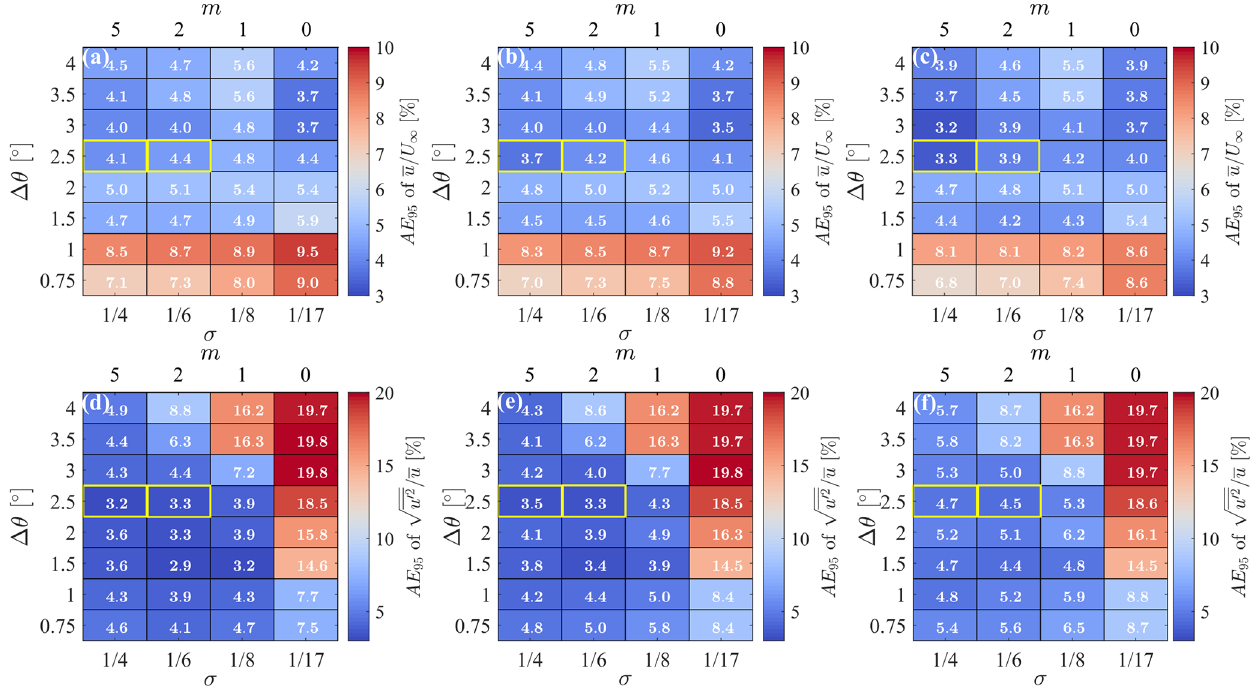
Figure 12. Error analysis of LiSBOA applied to virtual radial velocity fields: (a, d) ideal lidar; (b, e) step-stare lidar; (c, f) continuous lidar; (a, b, c) mean streamwise velocity; (d, e, f) streamwise turbulence intensity. The optimal configurations are highlighted in